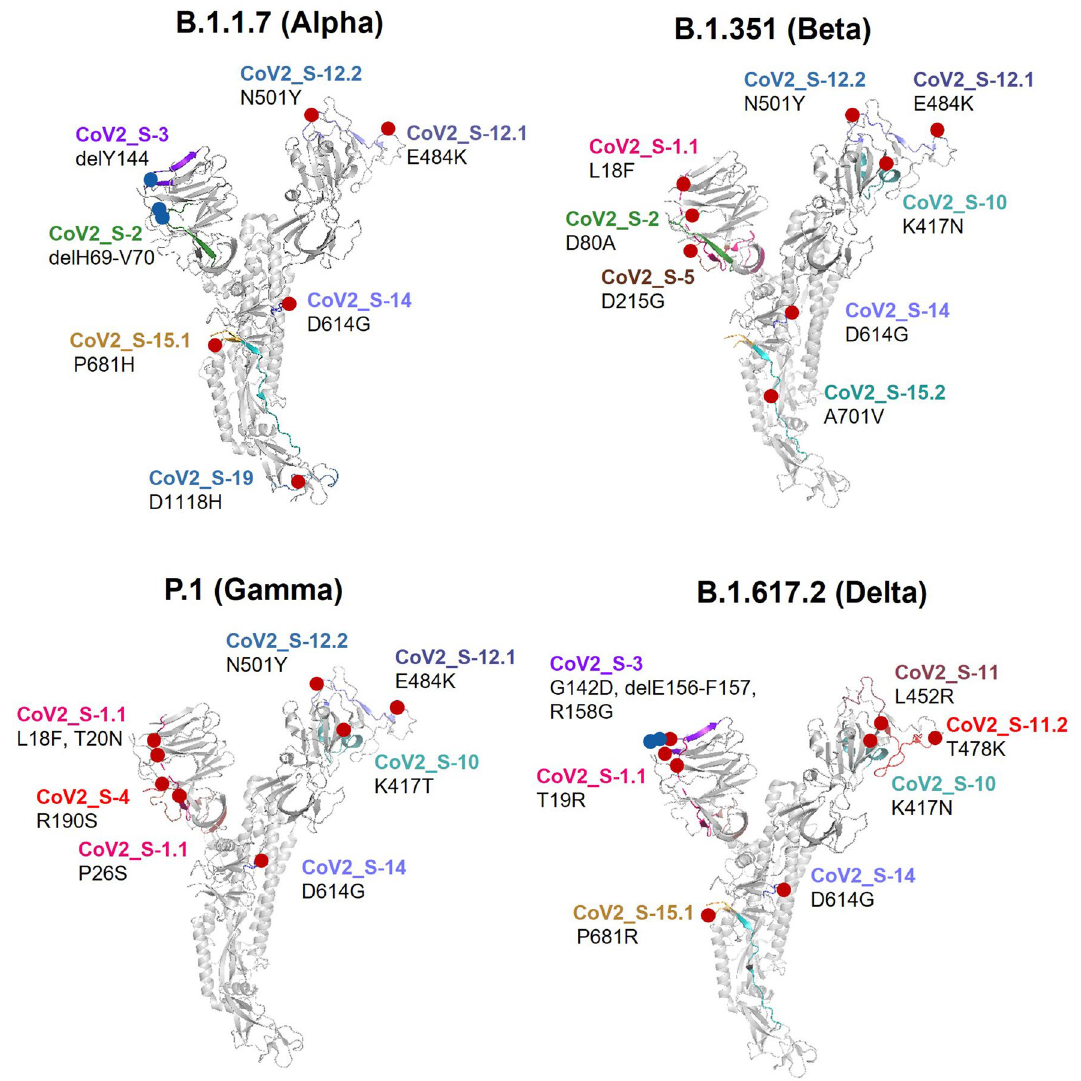
Figure 8. B cell epitopes in the Wuhan SARS-CoV-2 S protein with amino acid changes found in variants of concern. The structural cartoons depict amino acid substitutions and deletions in the S protein of four variants of concern (B.1.1.7 (Alpha), B.1.351 (Beta), P.1 (Gamma) and B.1.617.2 (Delta)) relative to location of B cell epitopes in the Wuhan SARS-CoV-2 S protein. Position of the amino acids is based on the Wuhan SARS-CoV-2 sequence. Locations of the amino acid substitutions and deletions on the structural cartoon are indicated with red and blue circles,